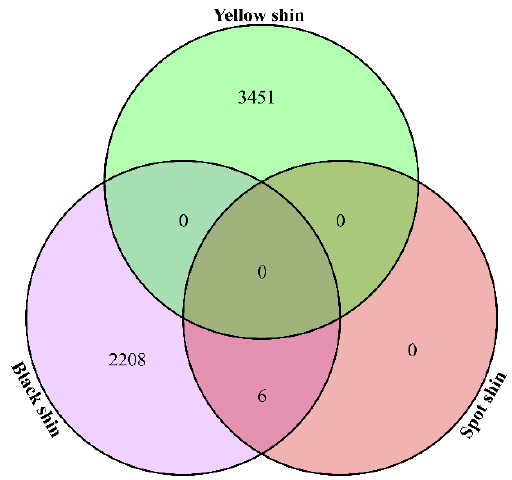
Figure 5. Venn analysis of all shin colors associated with significant SNPs.